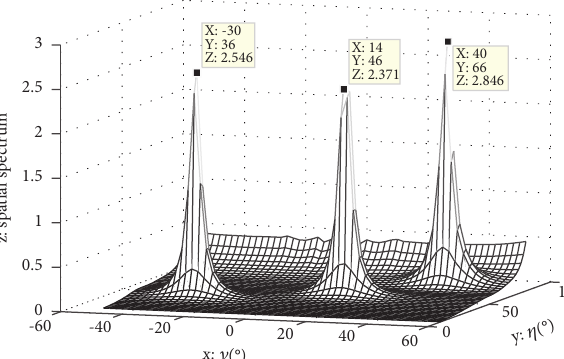
Figure 8: DOA refined estimation result.